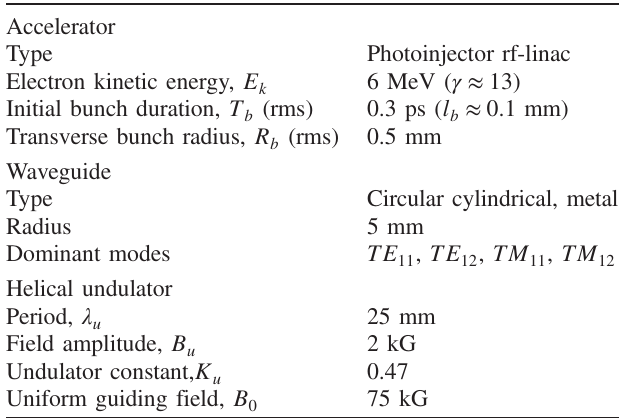
TABLE I. Basic parameters of the simulated THz